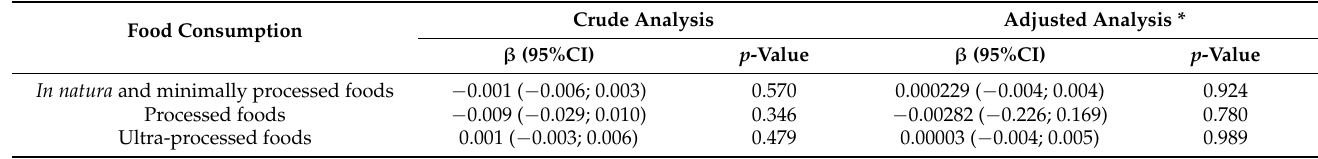
Table 3. Gross and adjusted analysis of the association of consumption of in natura or minimally processed, processed, and ultra-processed foods with sleep duration in adolescents. S ã o Lu í s, Maranh ã o, Brazil,